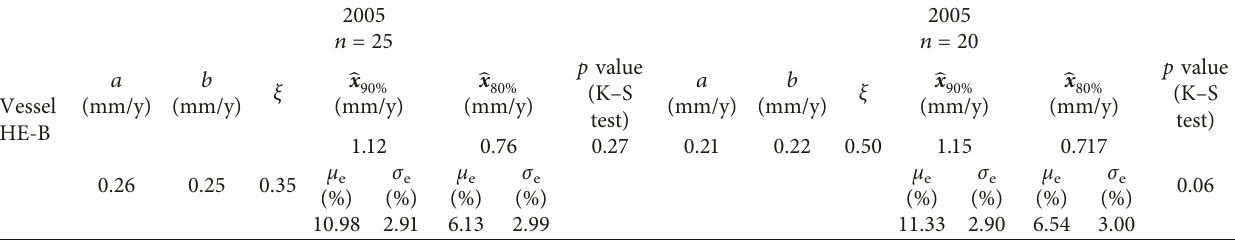
Table 4: GEV distribution parameters for HE-B with different numbers of sampling units ( n � 25 and n � 20) in 2005 and its corre- spondence error in comparison with the observed data.